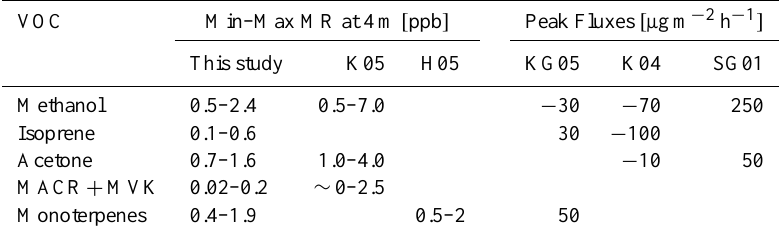
Table 1. A comparison of understorey minimum and maximum median mixing ratios and peak fluxes. Karl et al. (2005) (K05) and Karl and Guenther (2005) (KG05) were in a sweetgum and pine plantation. Holzinger et al. (2005) (H05) and Schade and Goldstein (2001) (SG01) were in a pine plantation. Karl et al. (2004) (K04) was in a tropical